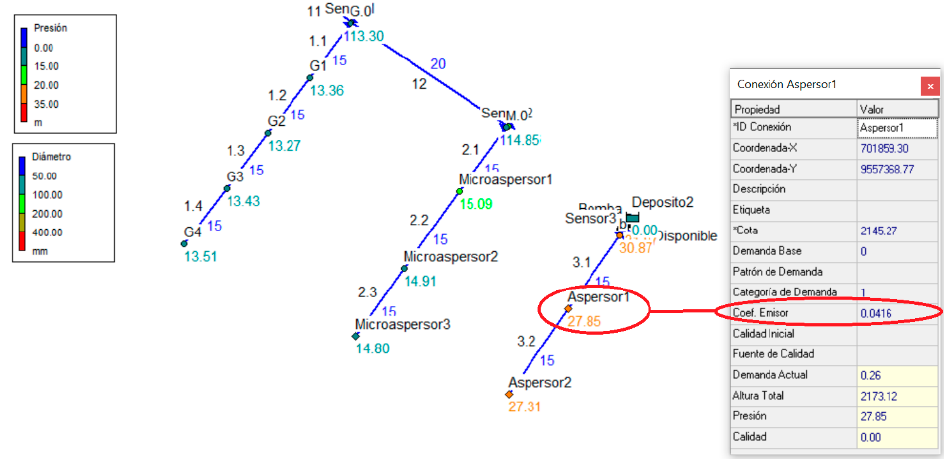
Figure 2. Analysis network modelled with calculated discharge coefficients.